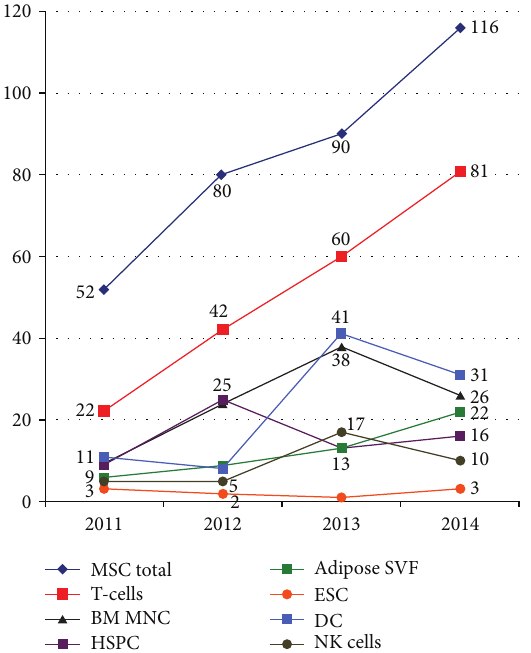
Figure 1: Number of stem cell therapy trials by cell type worldwide (reprinted from